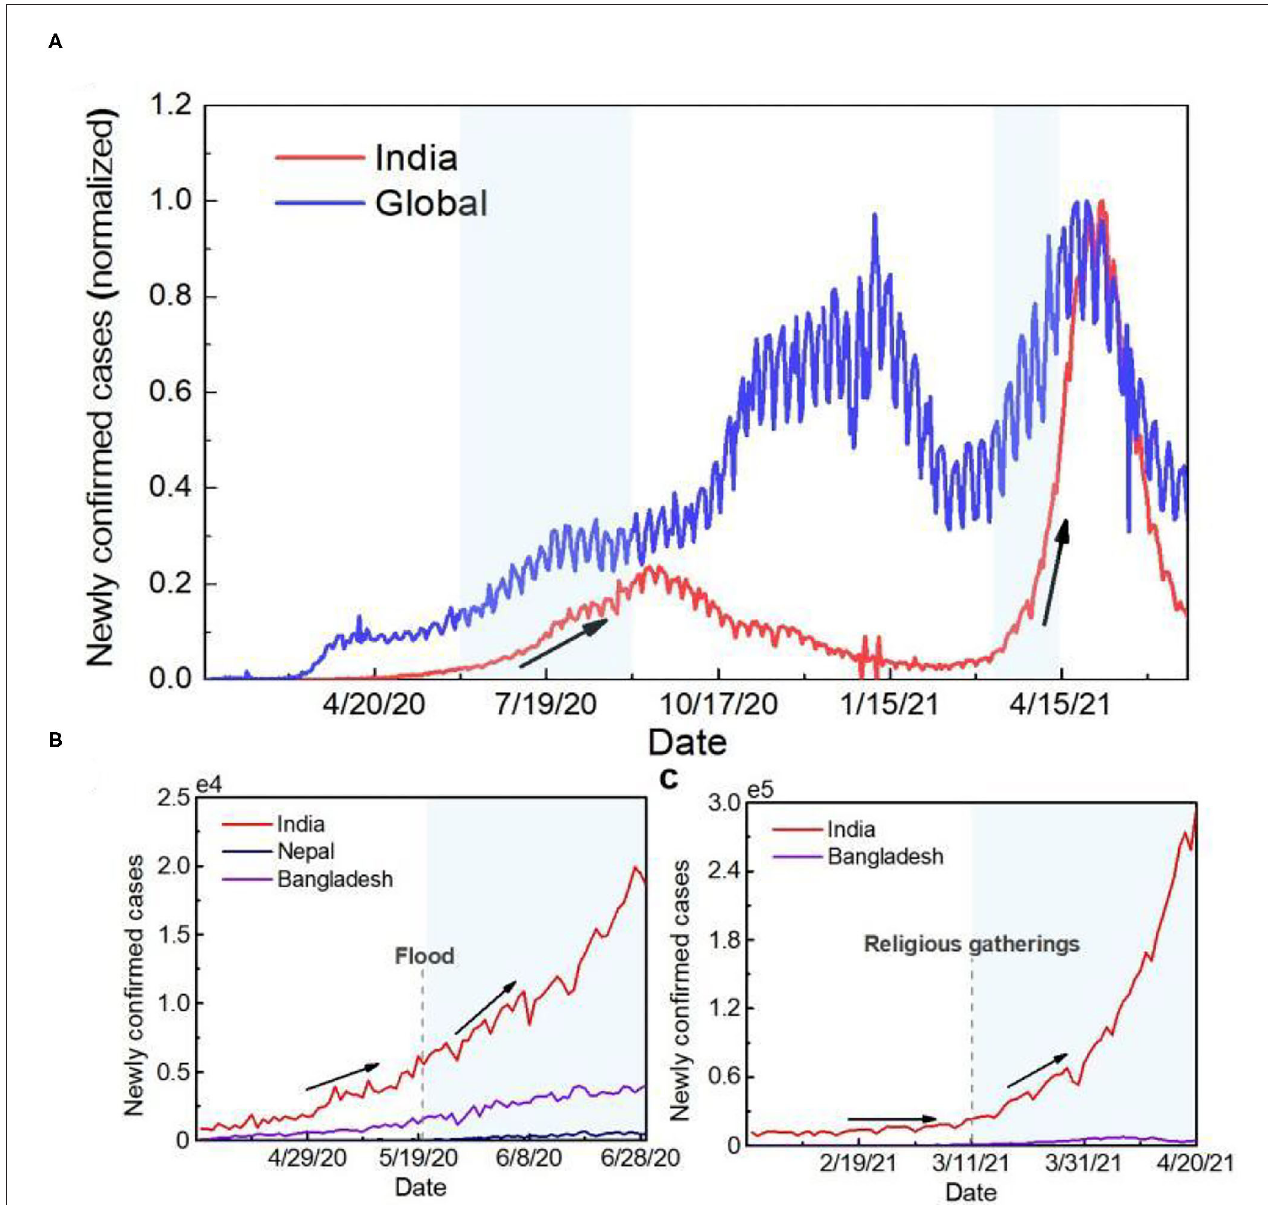
FIGURE 1 | Time series of the number of newly confirmed cases. (A) Time series curve of newly confirmed cases globally and in India. To facilitate the comparative analysis, the data were normalized. The red line represents newly confirmed cases in India, and the blue line represents global new cases. (B) Time series curve of newly confirmed cases in countries mainly affected by flooding during the first outbreak in India. The dotted line represents when the flood started. (C) Time series curve of newly confirmed cases in India and Bangladesh during the second outbreak in India. The dotted line represents the time when the crowd